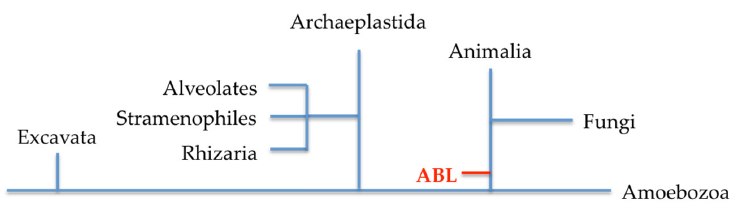
Figure 3. A phylogenetic relationship between fungal and plant lectins as presented by van Holle and van Damme [28].